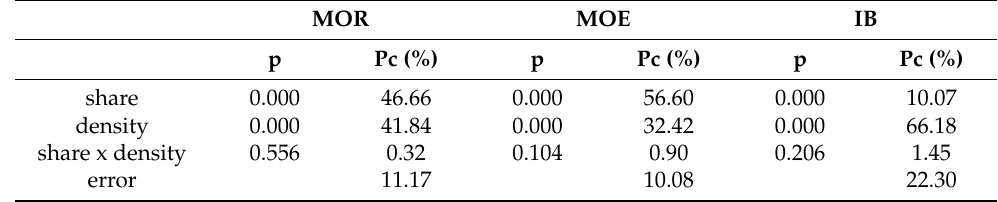
Table 5. Statistical significance of factor influences on mechanical properties of particleboards.